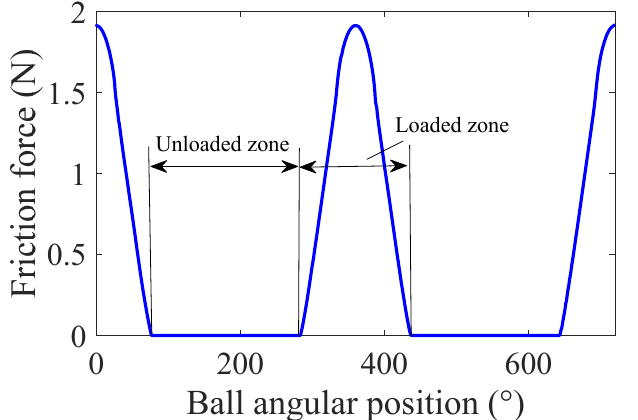
Figure 8. Friction force acting on the first ball versus angular position ( ω s = 2000 rpm, W = 2000 N, s c = 2%, μ m = 0.05).